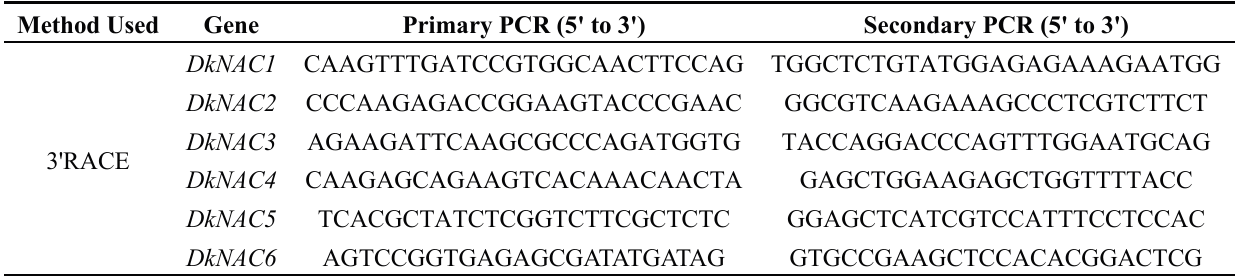
Table 1. Sequences of the primers used for gene